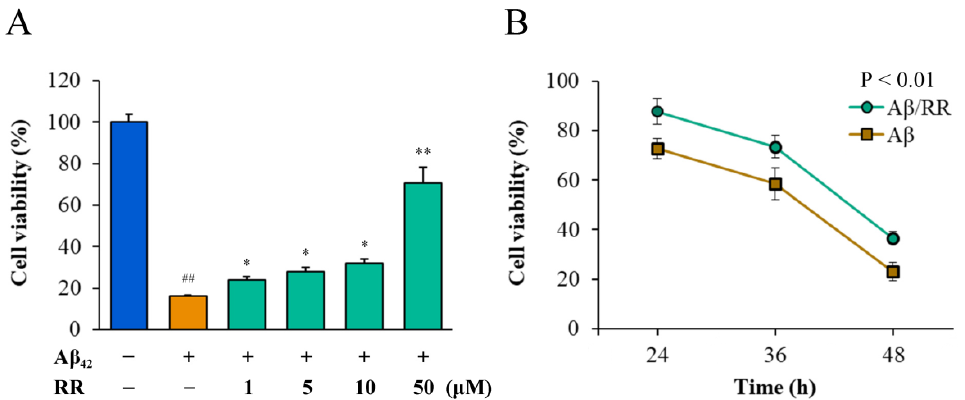
Figure 9. Effects of arginine dipeptide on cell toxicity induced by A β 42 secreted from SH-SY5Y cells. ( A ) Effects of arginine dipeptide (RR) on cell toxicity induced by 48-h treatment with A β 42 tested by MTT method. ( B ) Time-dependent effects of RR on cell toxicity of A β 42 . ## p < 0.01 versus A β 42 and RR non-treated group; * p < 0.05, ** p < 0.01 versus RR non-treated group, analyzed by one-way ANOVA followed by the Tukey’s post-hoc test for multiple comparison, n =